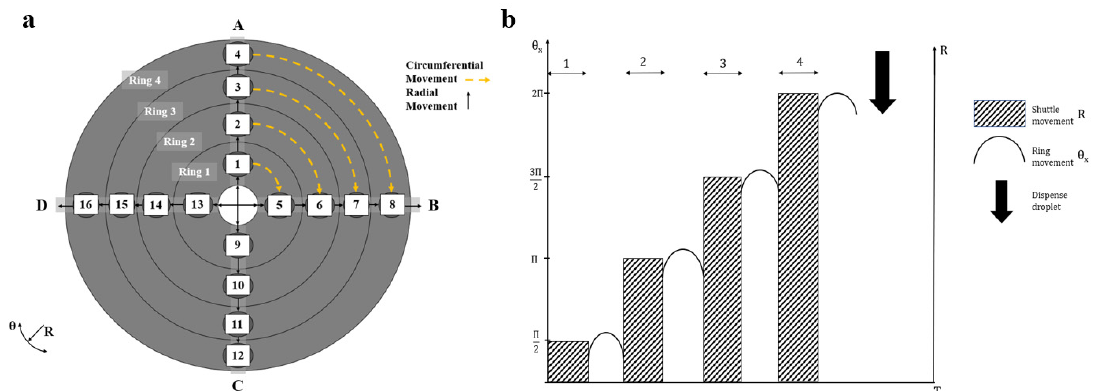
Figure 5. Movement on a four-by-four configuration. ( a ) 4 × 4 configuration. ( b ) illustrates the movement of the shuttles and rings. The shuttle and rings move in programable increments. It begins with the shuttle moving to the first ring to collect a droplet, the ring then rotates clockwise towards the next radii to collect the next droplet. These movements are performed until all the droplets are produced and the combinations dispensed.